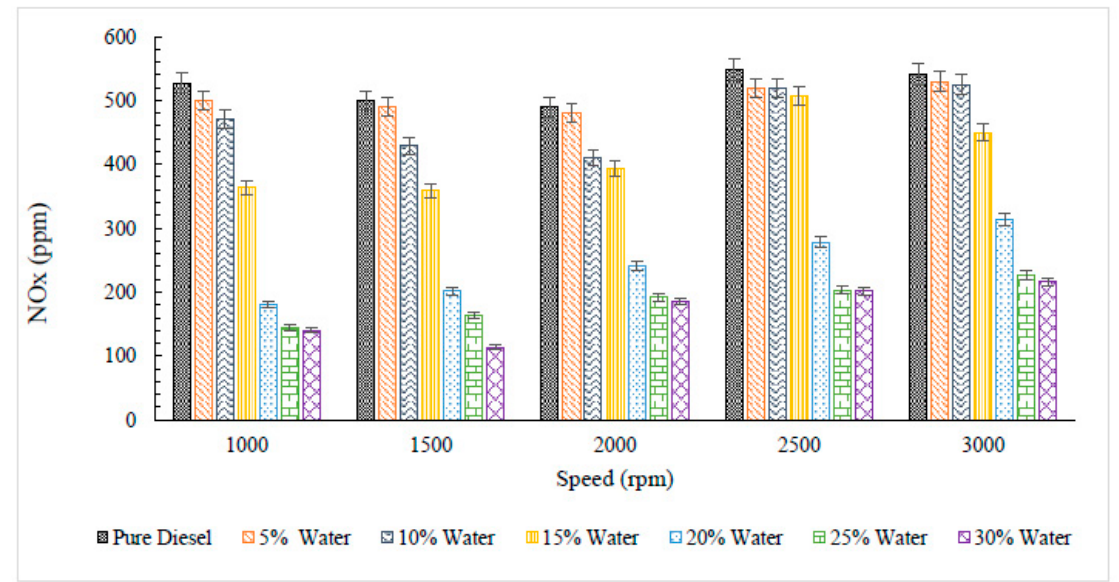
Figure 7. Effect of water-in-diesel emulsion fuel on nitrogen oxides emitted from a diesel engine at different engine speed.